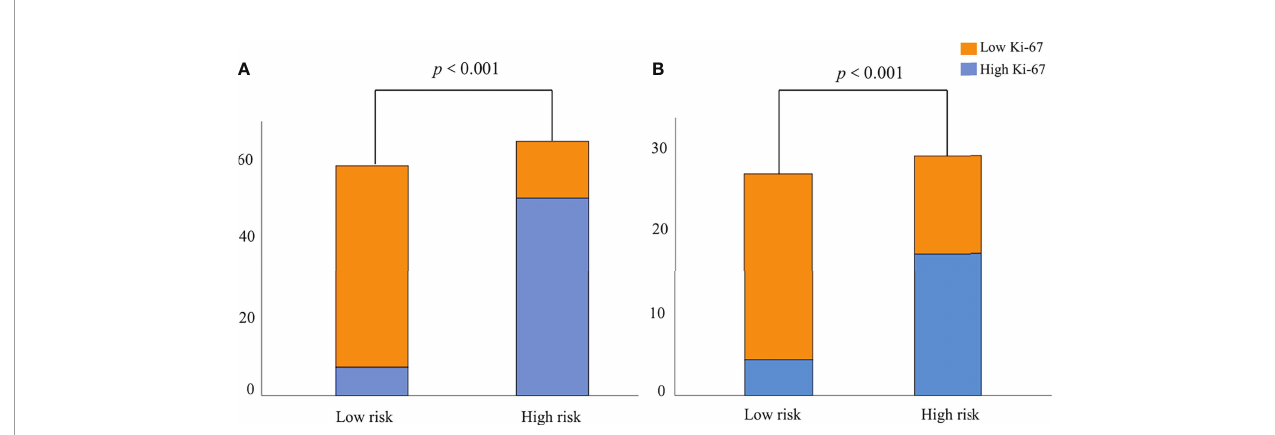
FIGURE 7 | The probability of high Ki-67 expression in the high-risk group was signi fi cantly higher than that in the low-risk group in the training (A) and validation (B) groups.